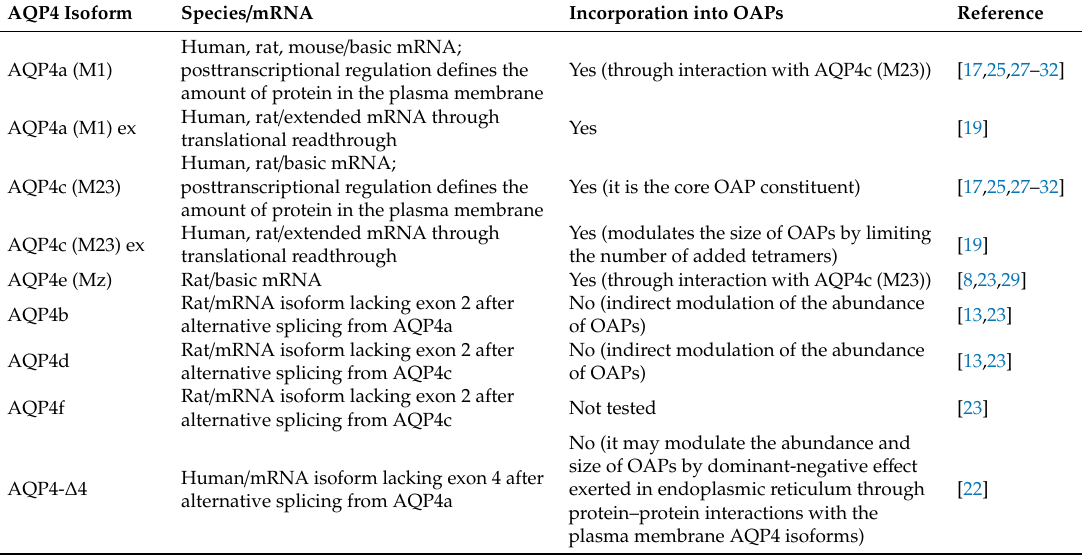
Table 1. AQP4 isoforms a ff ect the abundance and size of OAPs directly and